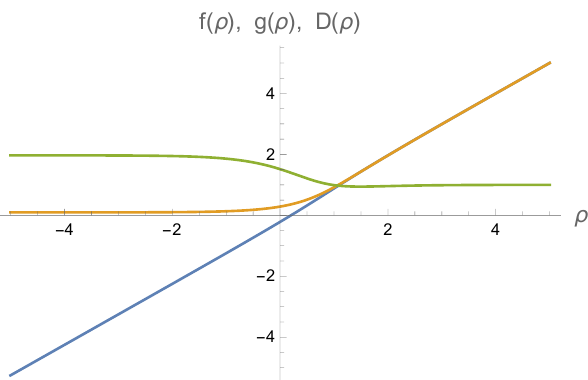
Figure 17. Flow functions for the S 2 compactification. The curves for f , g and D are blue, orange, and green